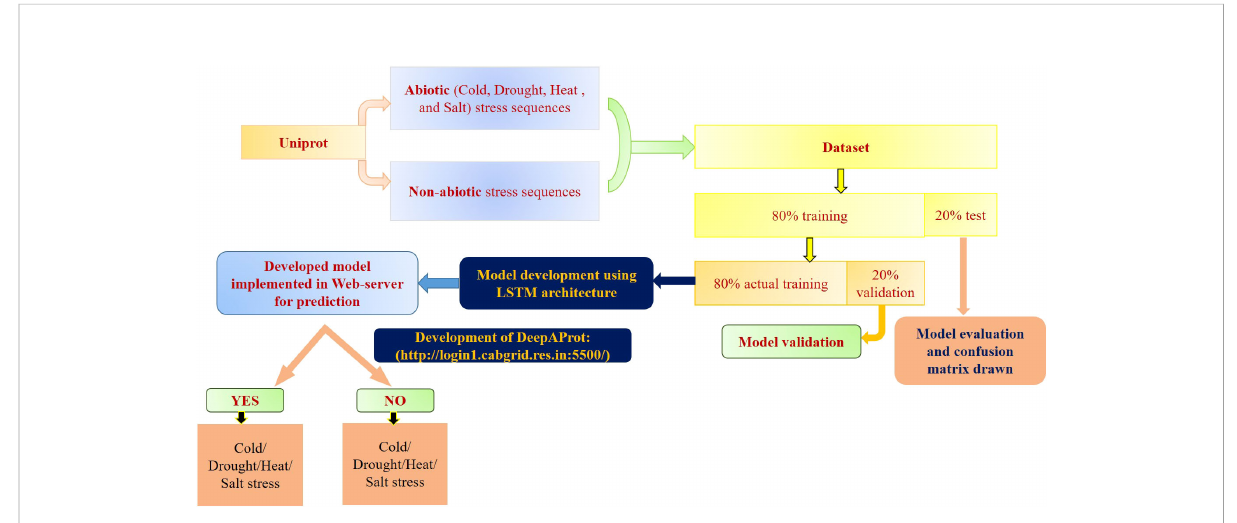
FIGURE 1 Schematic work fl ow for model implementation in the development of